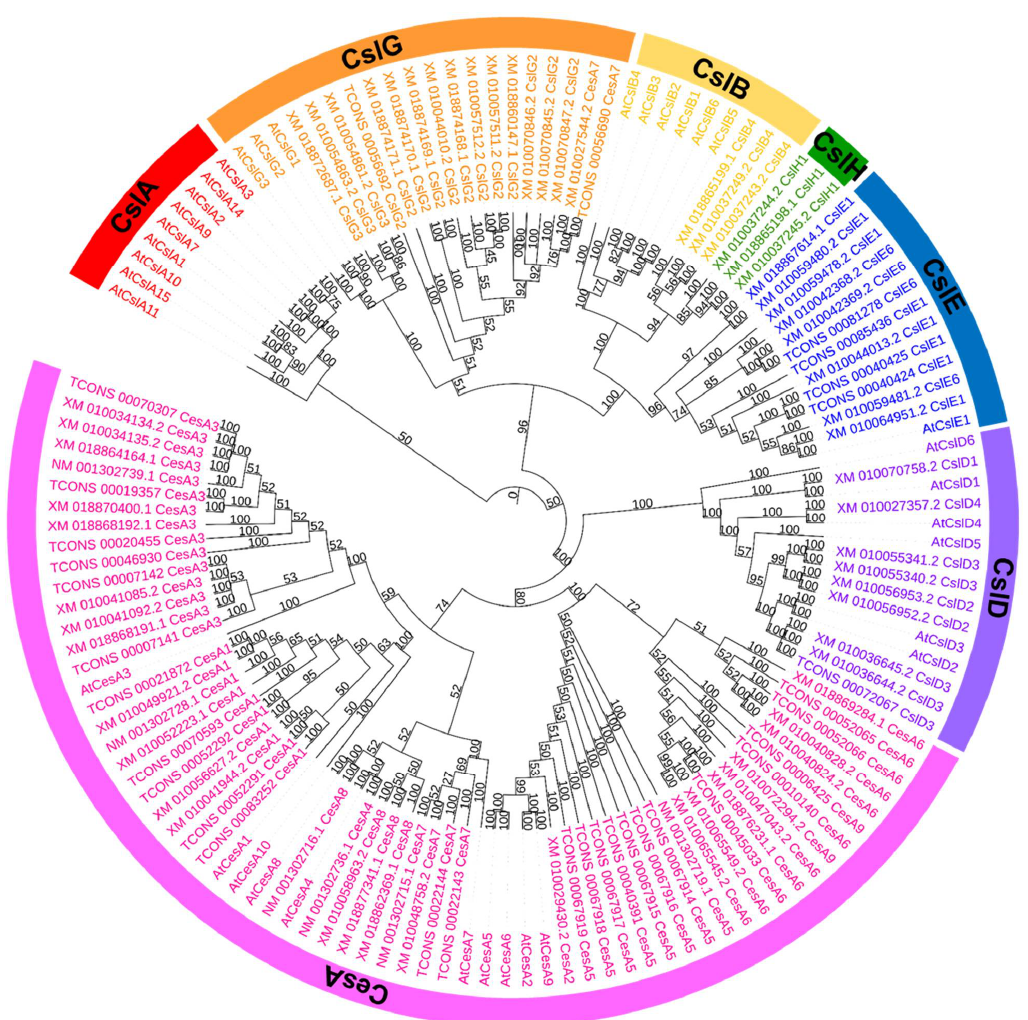
Figure 6. Phylogenetic tree of the transcripts of 100 CSs in the studies and 35 CSs of A. thaliana . Red labels indicate CslA cluster; orange labels indicate CslG cluster; yellow labels indicate CslB cluster; green labels indicate ClsH cluster; blue labels indicate CslE cluster; purple labels indicate CslD cluster; pink labels indicate CesA cluster.